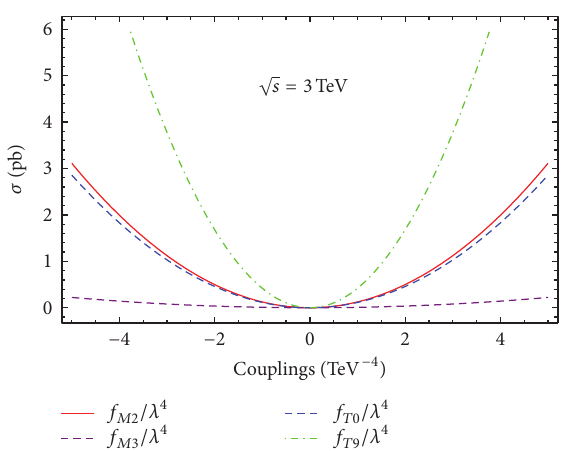
Figure 3: The total cross sections as function of anomalous 𝑓 𝑀2 /Λ 4 , /Λ 4 , 𝑓 /Λ 4 , and 𝑓 /Λ 4 couplings for the process 𝑒 + 𝑒 − → 𝑓 𝑀3 𝑇0 𝑇9 𝑒 + 𝛾 ∗ 𝛾 ∗ 𝑒 − → 𝑒 + 𝑍𝑍𝑒 − at CLIC with √𝑠 = 3